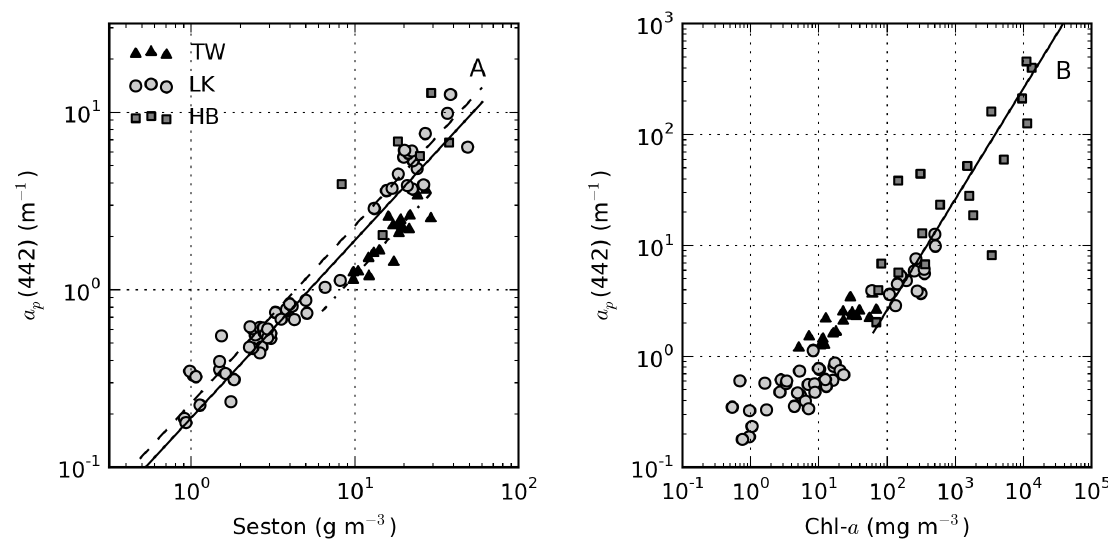
Figure 6. a (442) versus ( A ) seston showing linear fits for Loskop (- -), Theewaterskloof p (- · ) and combined data (–), and ( B ) chl- a showing the linear fit for Hartbeespoort (–). Note the log